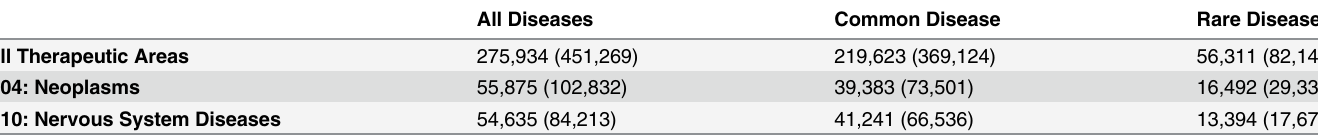
Table 3. Number of mappings for each disease type and therapeutic area post